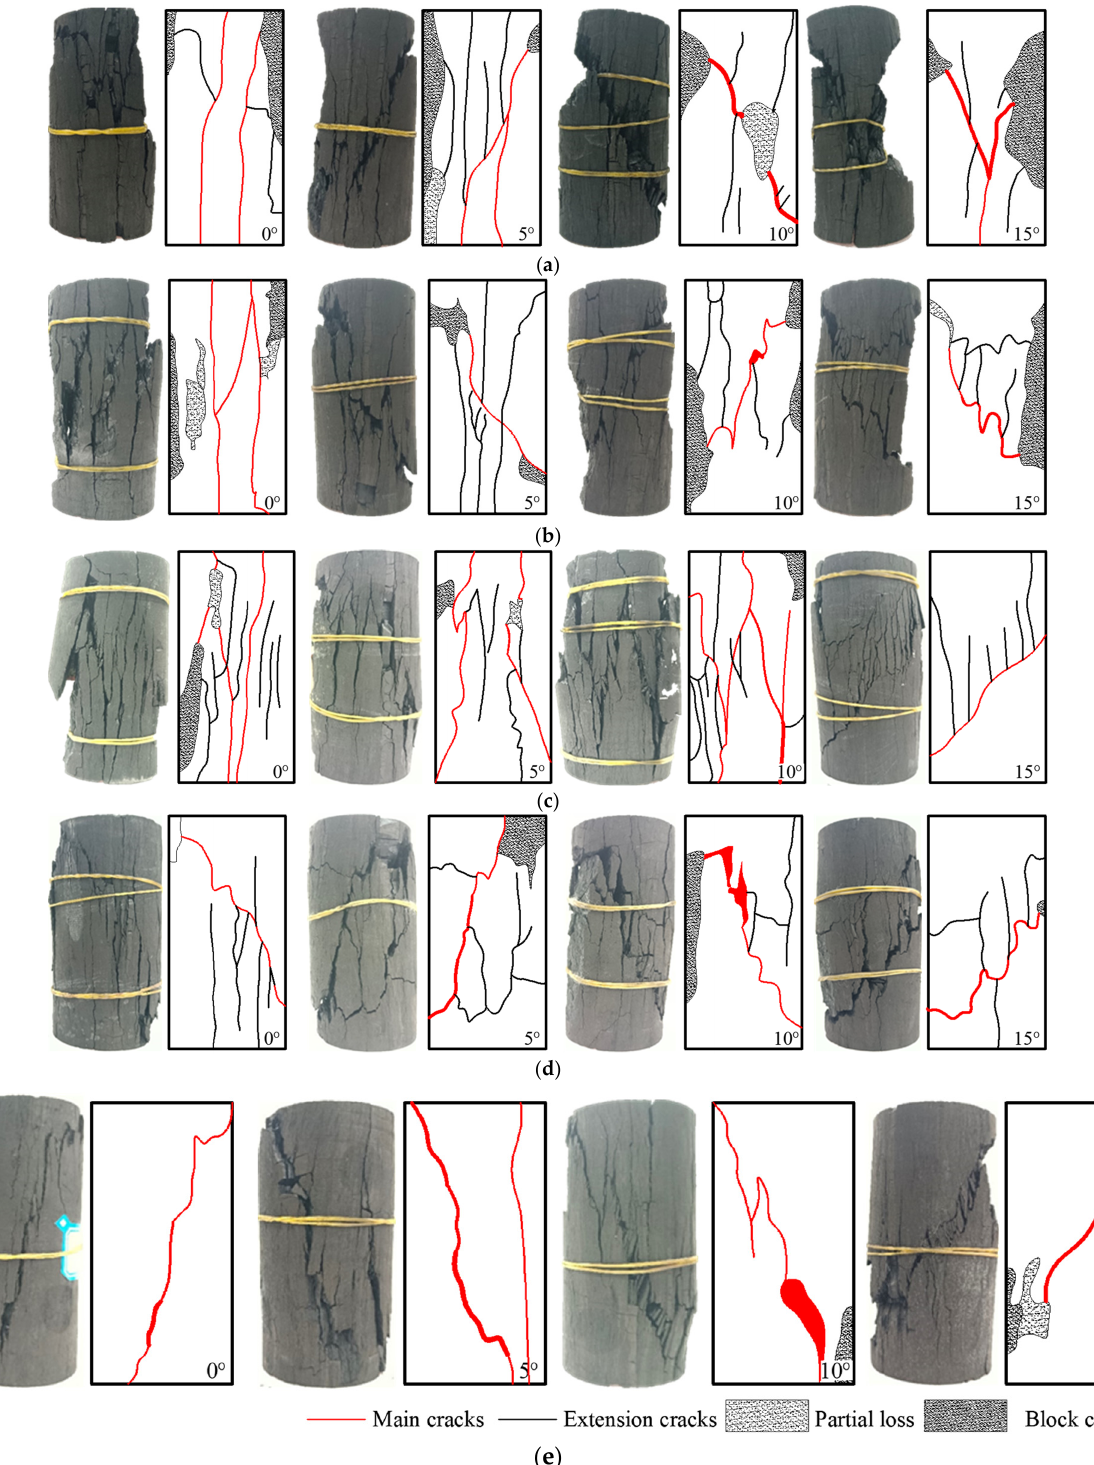
Figure 8. Different moisture contents and inclination angles. Macroscopic failure characteristics of lower coal specimens: ( a ) ω = 0%; ( b ) ω = 2.42%; ( c ) ω = 5.53%; ( d ) ω = 7.55%; ( e ) ω = 10.08%.